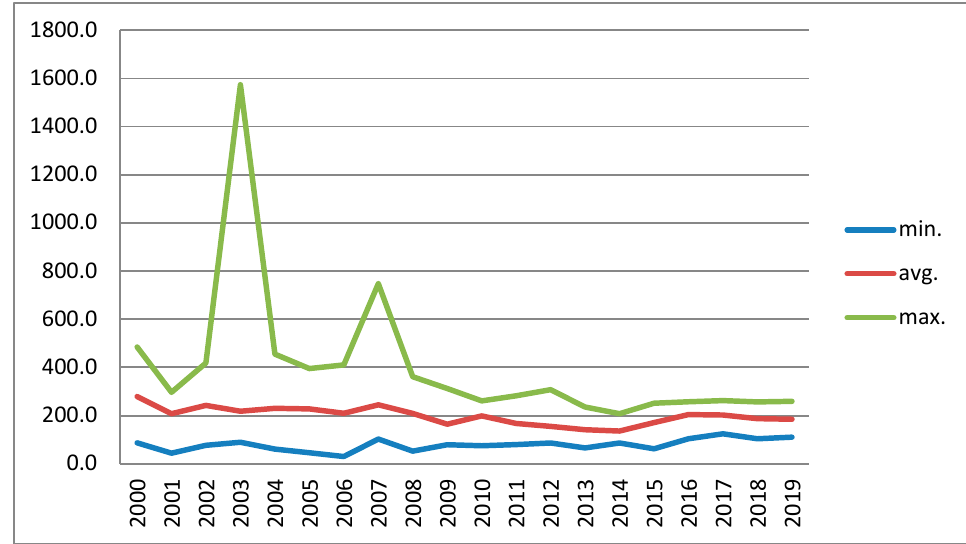
Figure 3. Annual wood prices [USD/m 3 ] of beech wood offered at the Krosno submission.